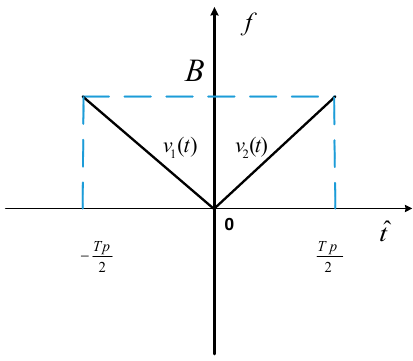
Figure 2. Sketch map of V-FM (V style modulation) waveforms.